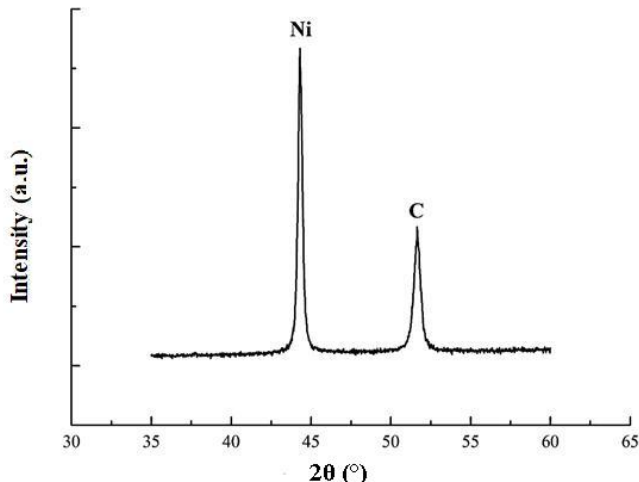
Figure 3. X-ray diffraction pattern of the Ni-GO CEC deposited at cathode current density i c = 10 A/dm 2 .